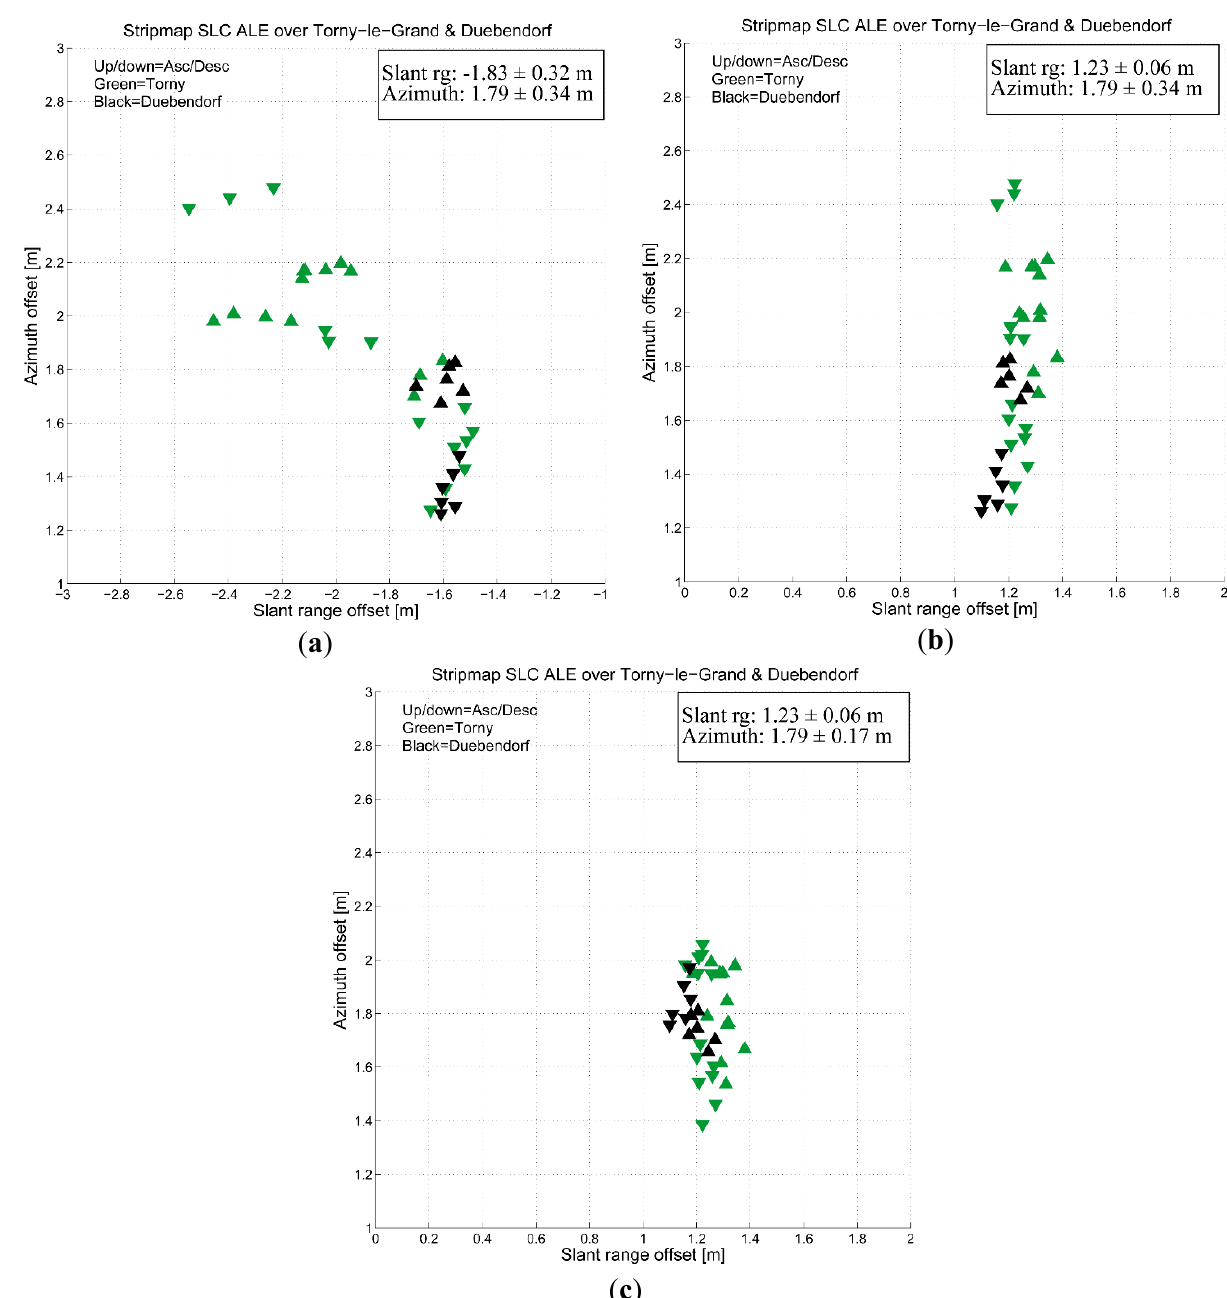
Figure 6. StripMap SLC ALE estimates based on precise state vectors; each point represents a single product over Torny-le-Grand (green) or Dübendorf (black); ( a ) no path delay or bistatic residual corrections; ( b ) path delay correction but no bistatic residual correction; ( c ) path delay and bistatic residual corrections applied. (a) no PD, no bistatic; (b) PD, no bistatic; (c) PD,